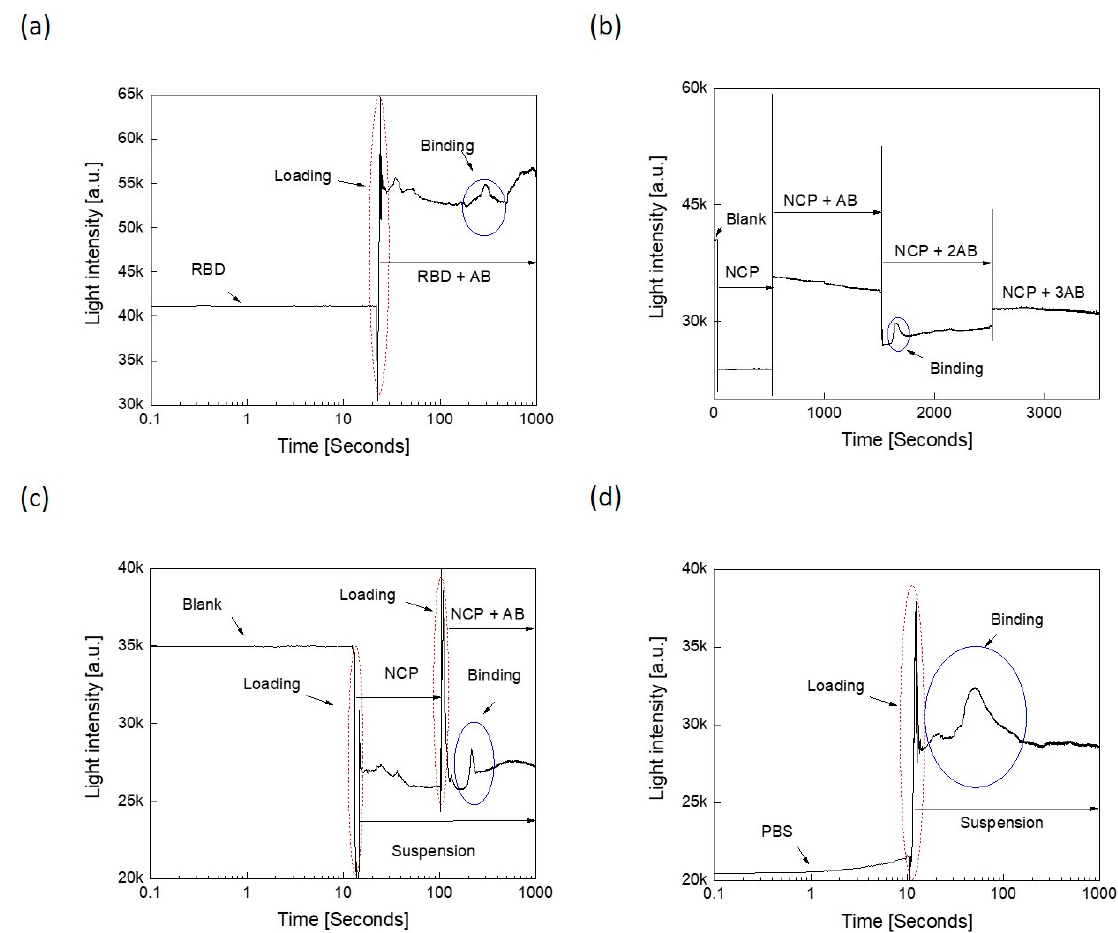
Figure 6. Optical detection of the binding affinities between: ( a ) the receptor-binding domain (RBD) of the spike protein with its antibody (AB), and ( b ) the nucleocapsid protein (NCP) and its antibody. The antibody was added again to NCP since no binding interaction was observed the first time. To confirm the result, the antibody was added a third time, but this time once again, the binding interaction was not apparent. ( c ) NCP binding with the antibody after mixing inside, and ( d ) NCP binding with the antibody after mixing outside. The interaction peak is circled.